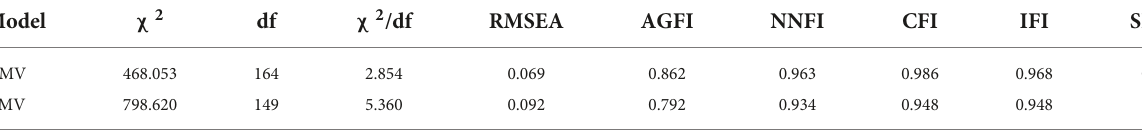
TABLE 2 CMV and UMV model comparisons of key parameters.